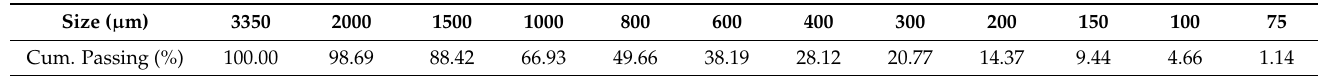
Table 5. Particle-size distribution